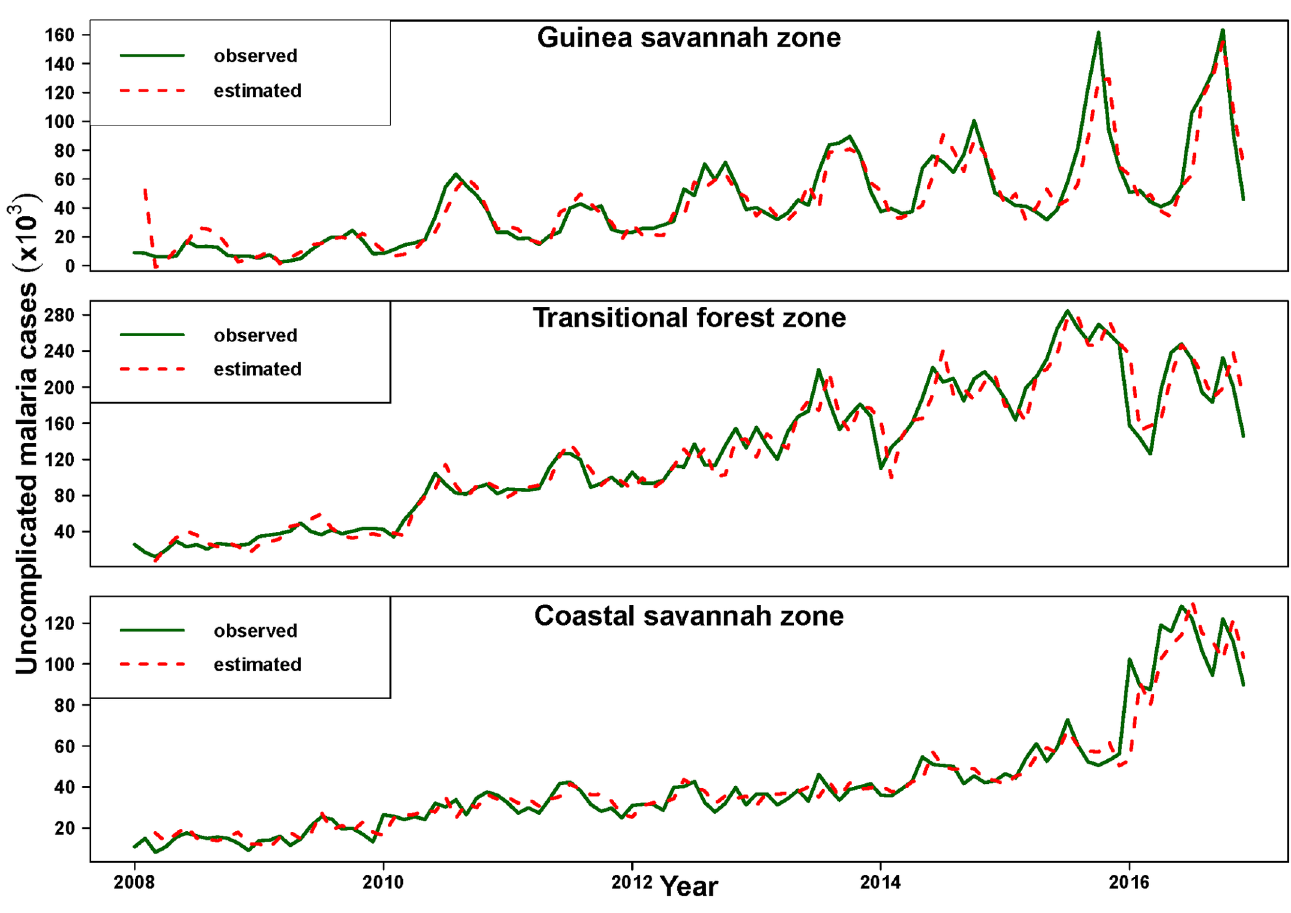
Fig 4. Predicated versus observed uncomplicated malaria cases by